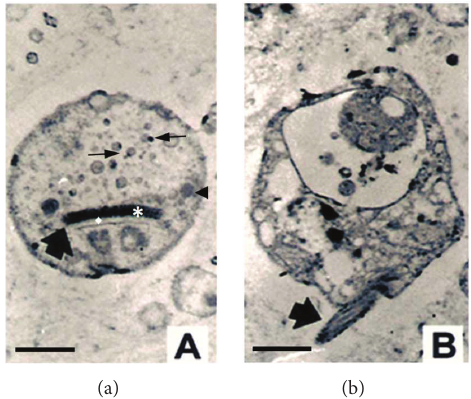
Figure4:Transmissionelectronmicrographsofintracellularmicro- organisms detected in the necrotizing space occupying lesion of the brain showed in Figure 4. Note the typical ultrastructure feature of a stercorarian amastigote. Figure 5(a) shows a transverse section of parasite with the discoidal kinetoplast (arrow) while Figure 5(b) shows the presence of a short flagellum or pseudoflagellum. In Figure 5(a), ( ∗ ) kinetoplast DNA, ( Q ) kinetoplast matrix, ( → ) acidocalcisomes, and ( 󳶣 ) glycosome. (Bar 0.4 𝜇